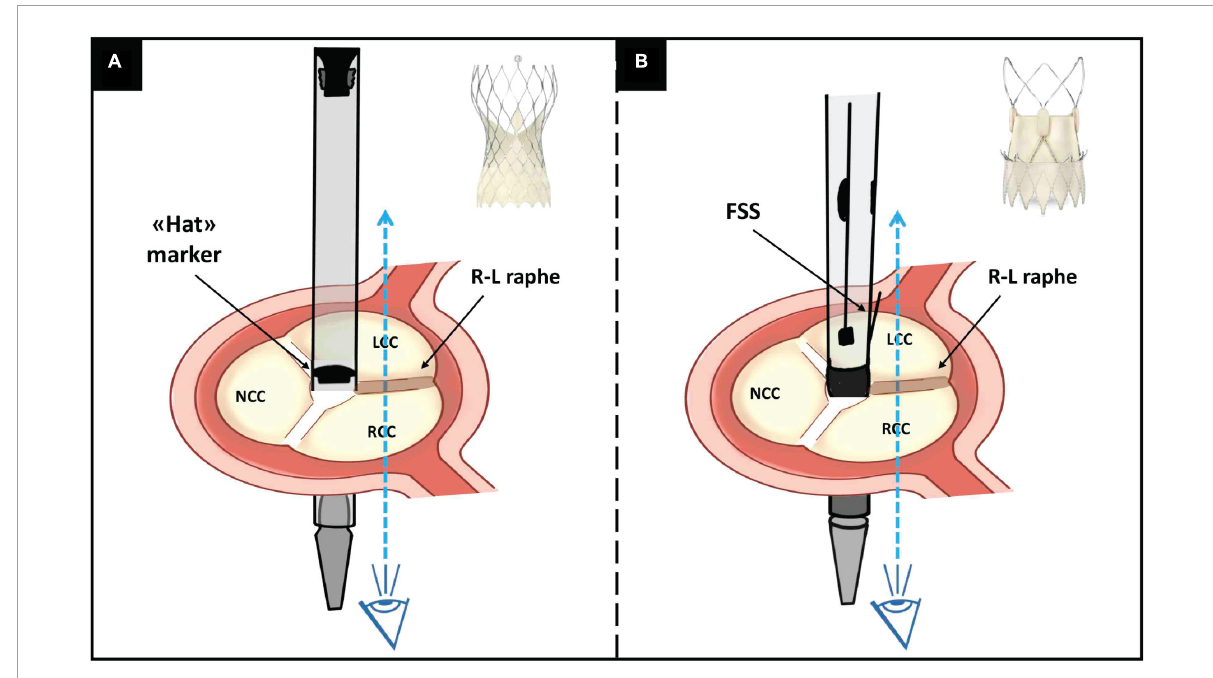
FIGURE1 Illustration of the R-L cusp overlap orientation technique for: (panel A) Evolut and (panel B) Acurate Neo2 THV. See the description in the main text. R, right; L, left; THV, transcatheter heart valve; NCC, non-coronary cusp; RCC, right coronary cusp; LCC, left coronary cusp; FSS, free stent